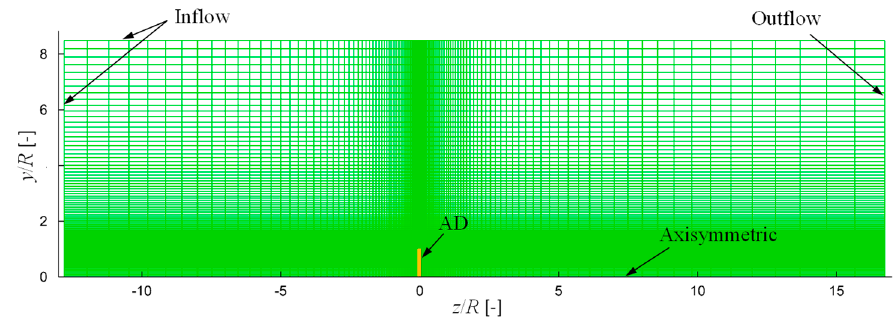
Figure 3. Mesh configuration for the Actuator Disc/Navier-Stokes (AD/NS) simulations.